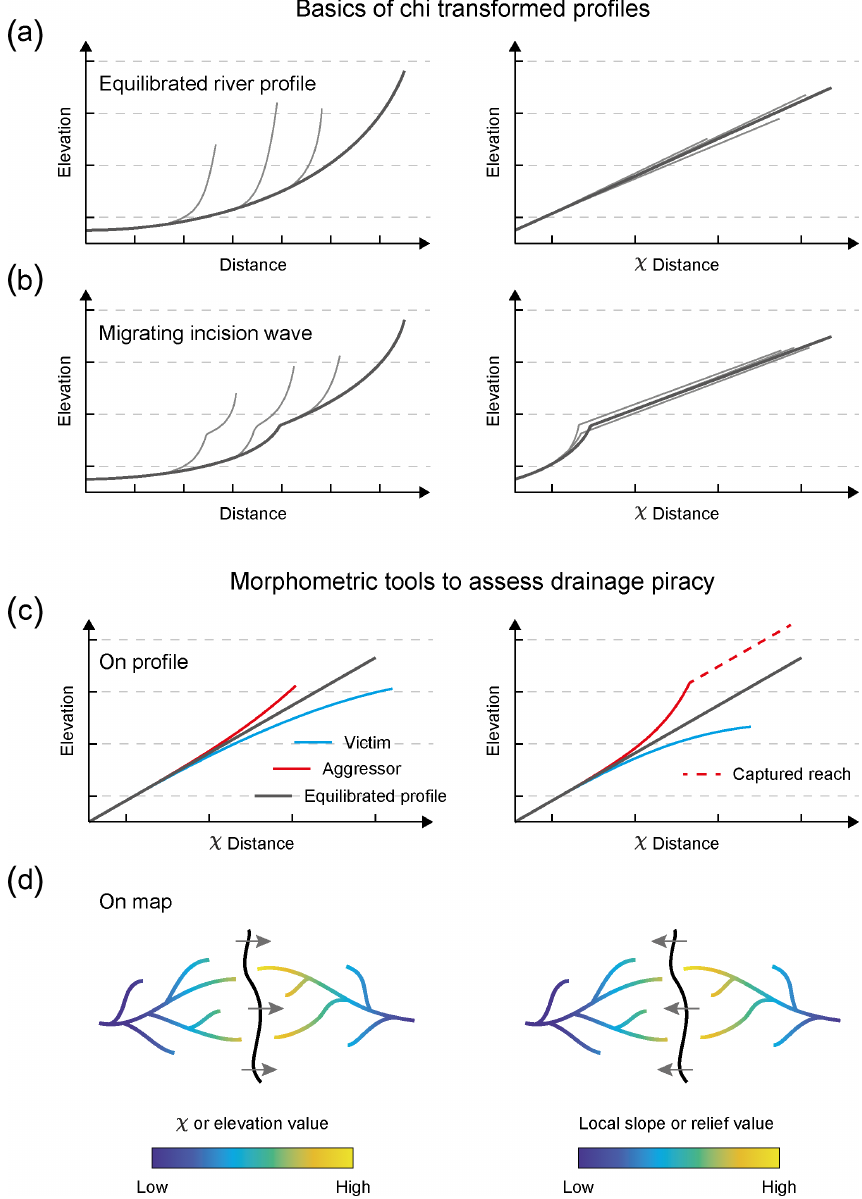
Figure 4. Schematic river profiles and metrics expected in the case of equilibrated rivers, of a wave of incision migrating upstream the river network, or of stream piracy and divide migration. (a) Longitudinal (left) and χ (right) profiles of a main trunk river (dark line) and its tributaries (grey lines) in the case that these rivers are in equilibrium with external forcing conditions that are constant over the whole area. The χ profiles of these various rivers are here all linear (constant forcing conditions) and colinear (same forcing conditions), within a certain variability related to natural conditions (Perron and Royden, 2013). (b) Longitudinal (left) and χ (right) profiles of a main trunk river (dark line) and its tributaries (grey lines) in the case of the migration of a wave of incision through the river network. Knickpoints are present along the various streams at variable locations, but their χ profiles are all concordant, within the variability due to natural conditions (Perron and Royden, 2013). (c) χ profiles expected in the case of migrating divides (left) or river captures (right). Aggressor (or pirate) stream is represented in red, and the victim in blue. The dark line represents the profile expected for rivers equilibrated with external forcing. Area gain shifts the χ profiles of aggressor streams to lower χ values, above the equilibrium line. Conversely, area loss shifts the χ profiles of victim streams to higher χ values, below the equilibrium line. Here, χ profiles are discordant (Willett et al., 2014). (d) Assessment of divide migration and its direction from the across-divide contrast in χ (Willett et al., 2014) (left) or in Gilbert metrics such as local slope or relief (Whipple et al., 2017b; Forte and Whipple, 2018)